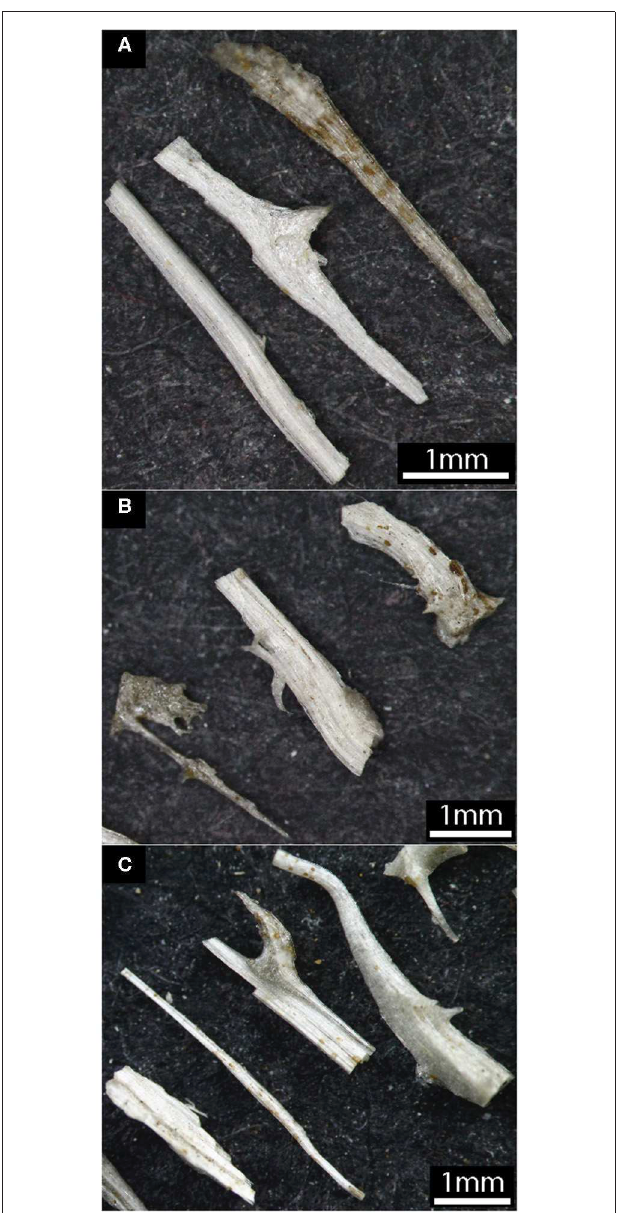
FIGURE 4 | Optical microscope images of 0 and 1 φ Elongate tube-vesicle particles from HVR070. Clasts are relatively simple with highly elongate shapes and typically a single shearing fabric. Clasts with more-complex forms display abrupt changes in shearing fabric (A) , delicate hair-like strands of glass (B) , or twisted ribbon shapes (C) . The particle shapes were produced by varied deformation prior to